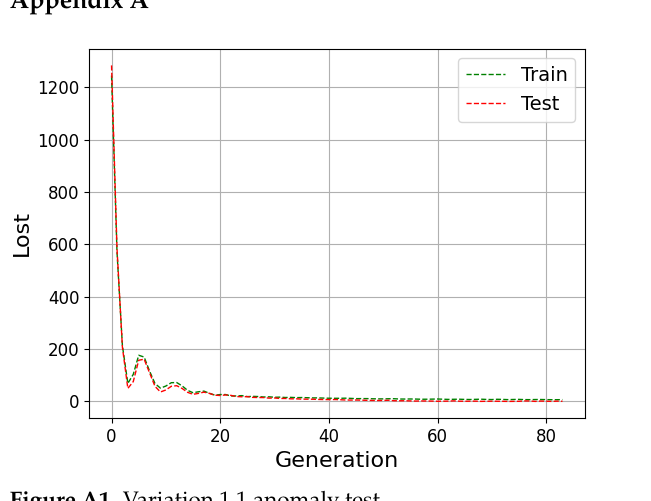
Figure A1. Variation 1.1 anomaly test.